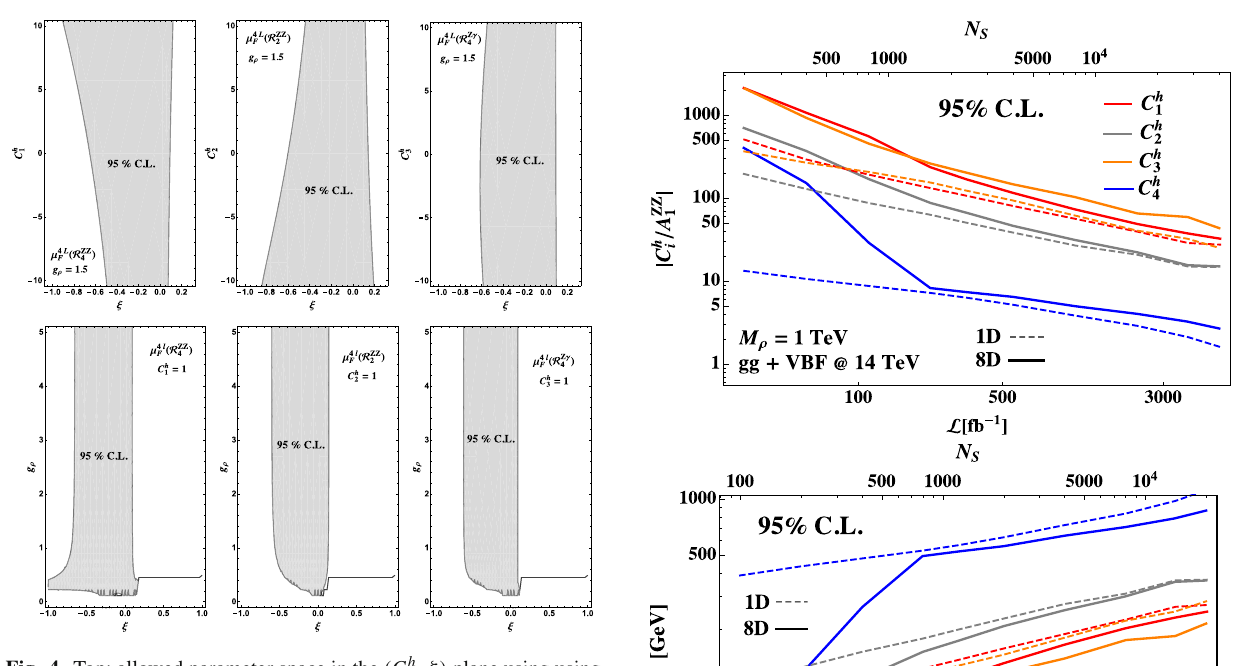
Fig. 4 Top: allowed parameter space in the ( C h tom: same as top, but in the ( g ρ ,ξ) plane